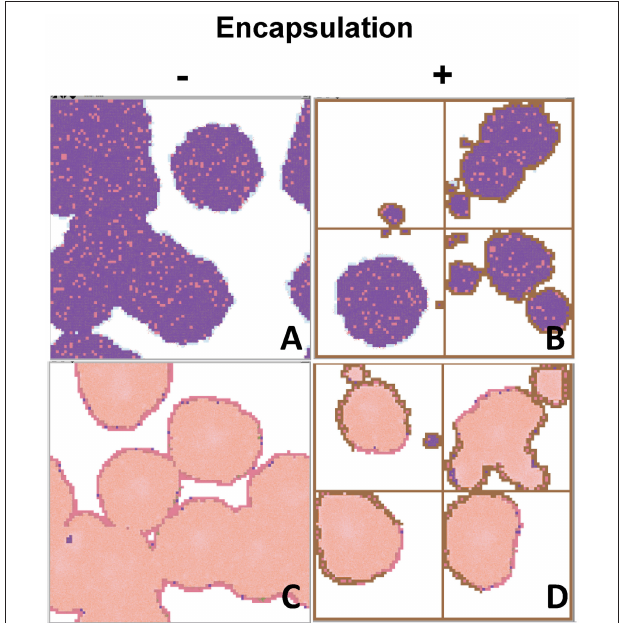
FIGURE 11 | Interface of the program using four-times more patches to show how important the encapsulation process is in a wider grid as regards stopping the progression toward active TB. This is the case of a typical proliferative response, with low BLTOL and high BAM (A,B) , and a medium BLTOL and low BAM (C,D) , after running the program until day 46 post-challenge. Colors: Alveoli: White : when a single AM is present; Black : when the AM is destroyed; Blue : when the AM is destroyed and replaced by another AM from the interstitium; Violet : when an activated AM (aAM) is present; Pink : when neutrophils occupy the alveoli; Brown : capsule. Bacilli: Blue challenge bacilli; Red : Intracellular bacilli (Ibac); Green : Extracellular (Ebac); Brown : growing Ebac; Orange : dormant (Dbac); Yellow : killed bacilli